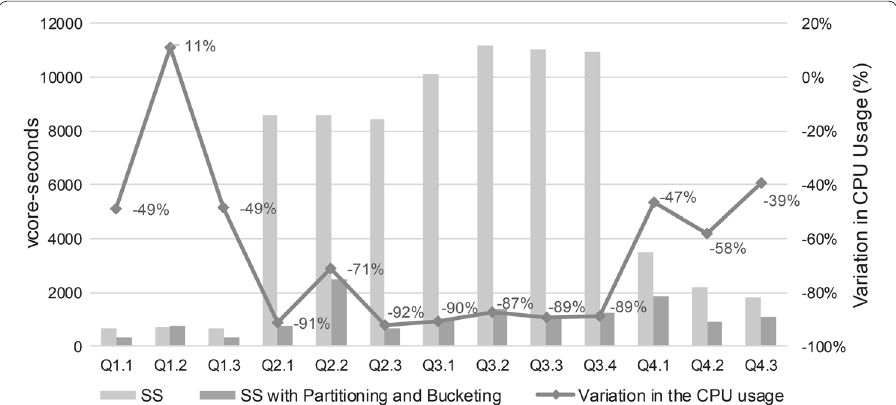
Fig. 11 CPU usage: multiple partitioning by “Od_Year” and “S_Region” and bucketing by “Suppkey” (Hive; SF =